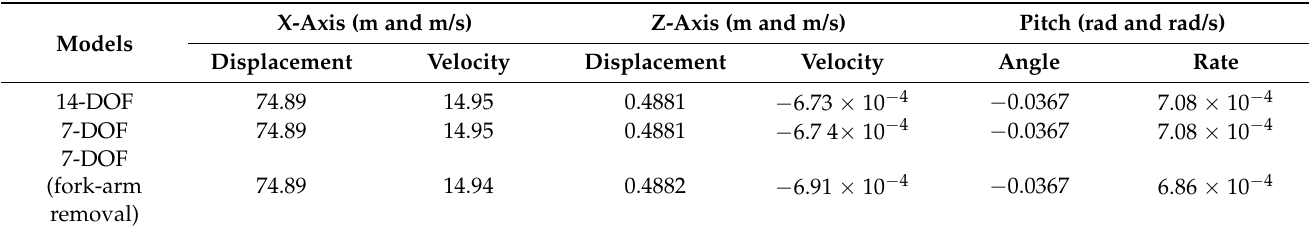
Table 4. The numerical results after 5 s simulation (sloping road).